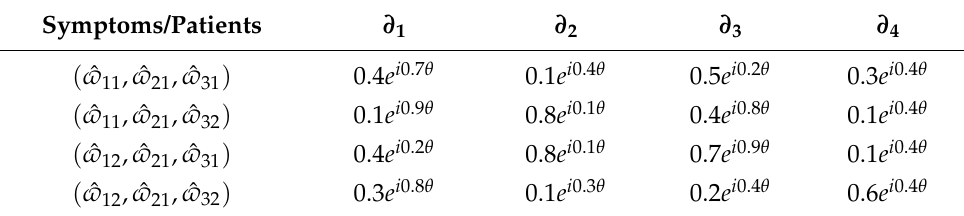
Table 4. z 1 F : Symptoms from F on the first day of patient’s treatment.